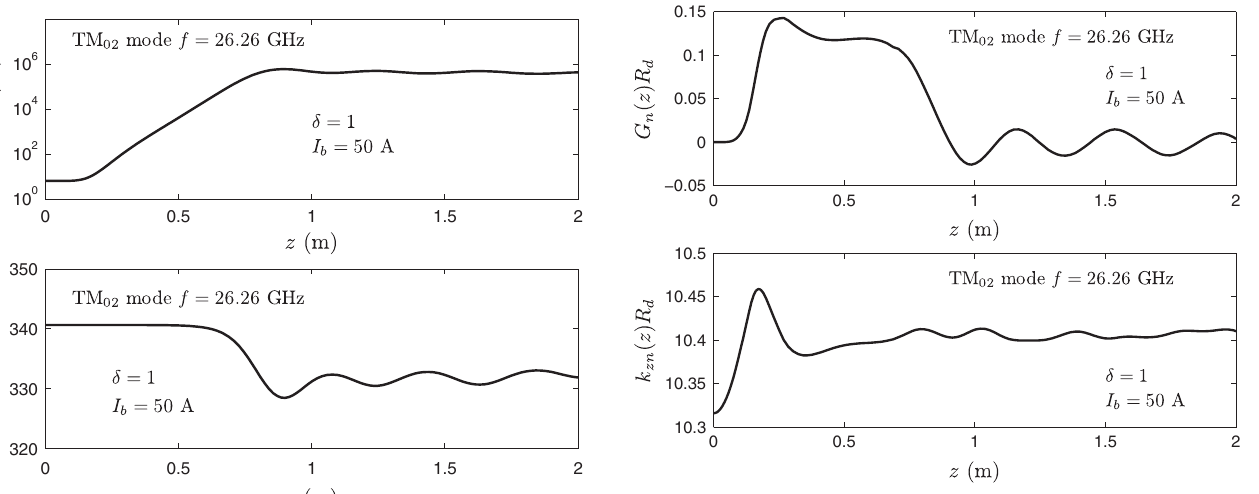
FIG. 9. TM 02 instantaneous normalized growth rate and wave number at 26.26